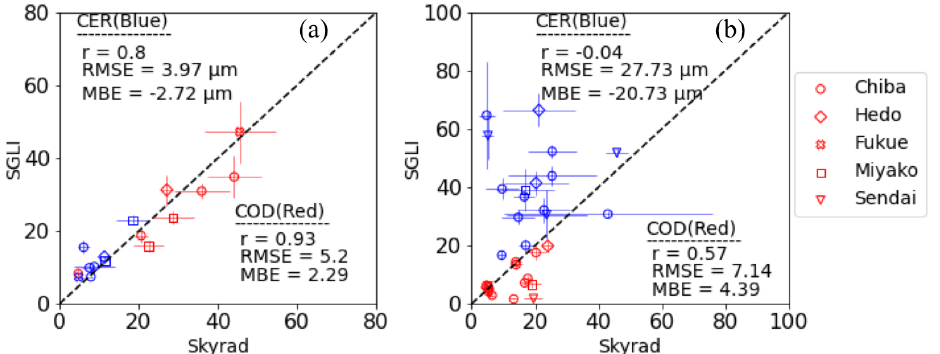
Figure 3. Comparison of cloud properties (COD and CER) between the sky radiometer and SGLI for (a) water clouds and (b) ice clouds by selecting data samples with a coefficient of variation (COV) of less than 0.2 for CODs of both sky radiometer and